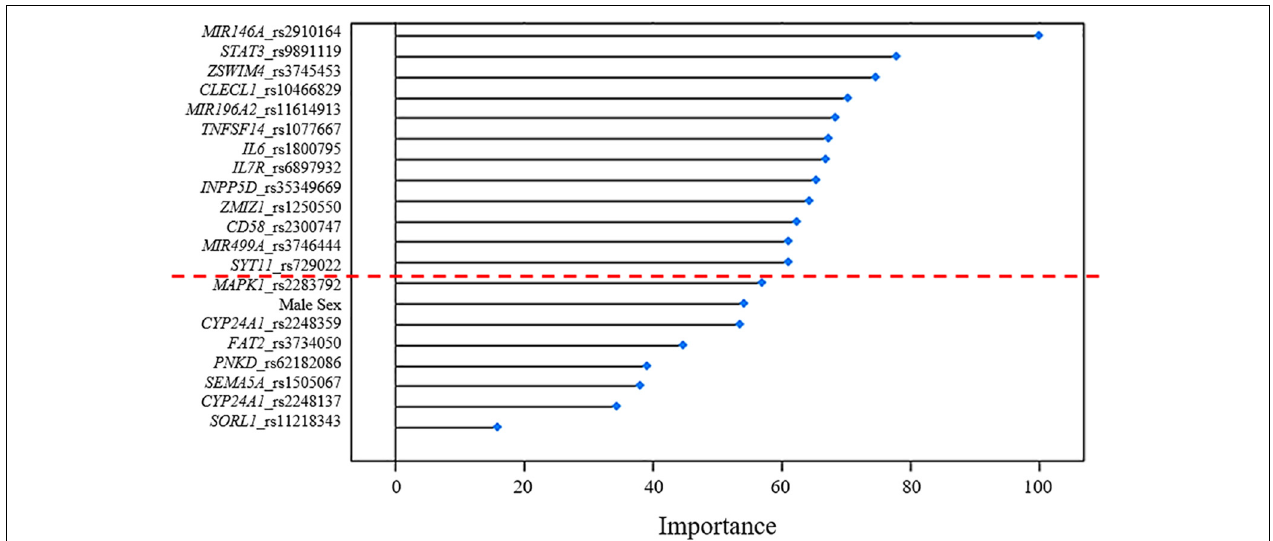
FIGURE 2 | Variable importance plot showing the contribution estimated for each variant associated with aMCI to the predictive model. These estimates (reported in terms of importance score on the x-axis of the plot) are standardized to achieve a maximum score of 100. The red dashed line indicates the most relevant predictors with a score > 60.